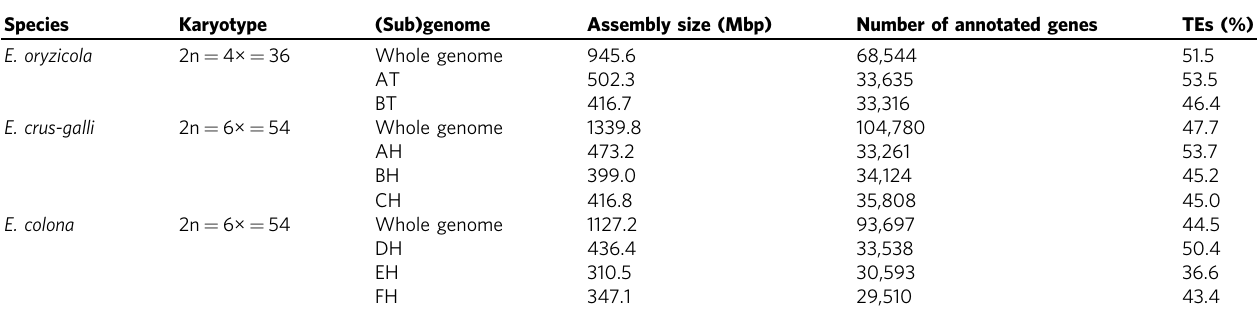
Table 1 Summary of the assembly and annotation of Echinochloa reference genomes.